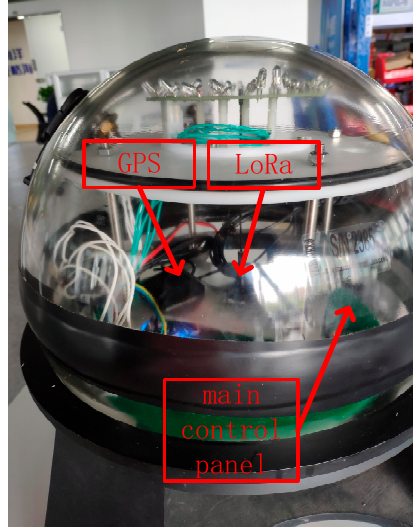
Figure 13. Beacon Figure 13. Beacon structure.